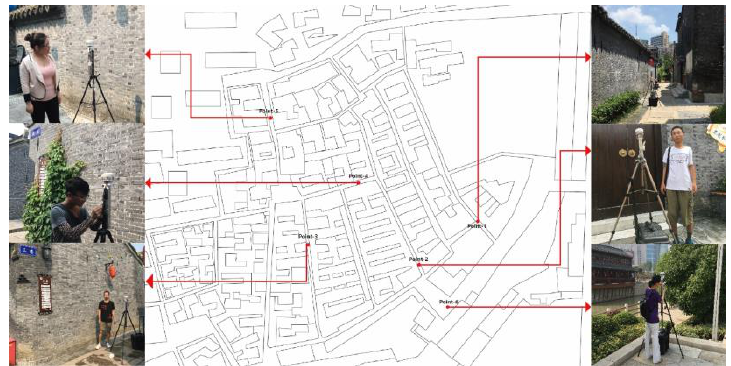
Figure 3. The selected points of this study [18].